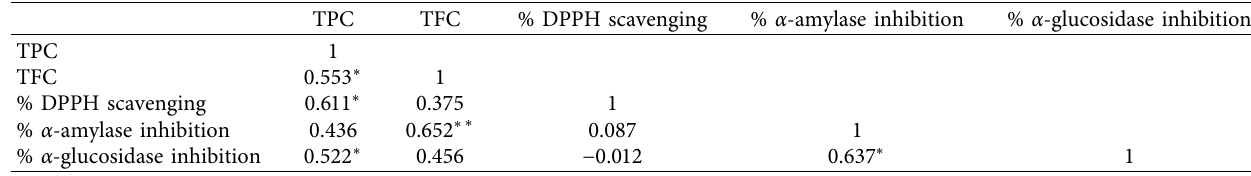
Table 6: Correlation analysis of phenolics, flavonoids, antioxidants, and enzyme inhibitory effect.